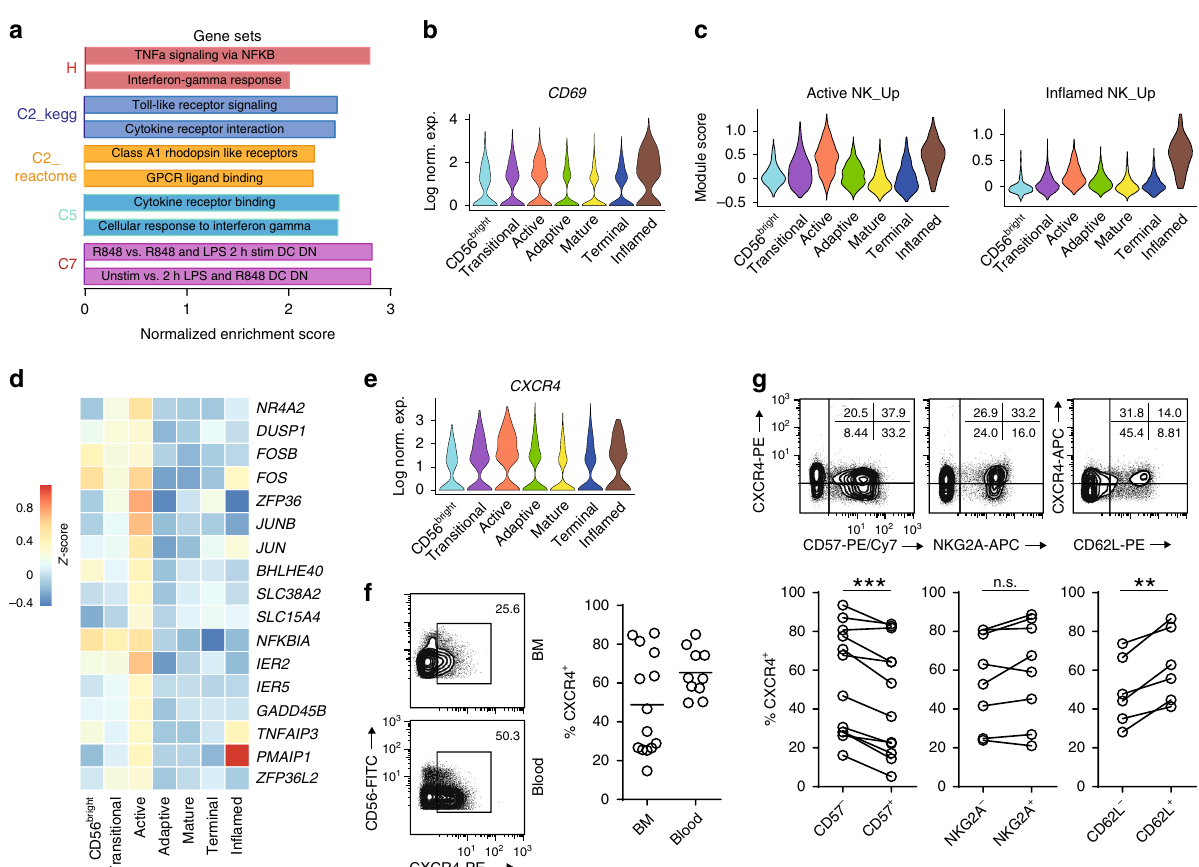
Fig. 4 Active NK cells with a unique transcriptome pro fi le. a Top two enriched gene sets (ranked by normalized enrichment score) of fi ve different datasets from GSEA of the “ In fl amed NK ” cluster compared to the rest of the cells were plotted. b The expression of CD69 in the BM sample was shown as a violin plot. The y -axis represents log-normalized expression value. c Module score was calculated using up-regulated DEGs of “ Active NK ” (left) or “ In fl amed NK ” (right) cluster from BM sample and plotted via violin plots. d Up-regulated IEGs from “ Active NK ” cluster were plotted using heatmap of the BM sample. e The expression of CXCR4 in the BM sample was shown as a violin plot. The y -axis represents log-normalized expression value. f Percentage of CXCR4 + NK cells (gated on Lin − CD56 + cells) was evaluated via fl ow cytometry. g The expression of CXCR4 in CD57 + / − , CD62L + / − , or NKG2A + / − CD56 dim NK populations from BM was assessed via fl ow cytometry (top). Percentage of CXCR4 + cells within each population were quanti fi ed (bottom). n ≥ 6 from two to fi ve independent experiments. Paired Student ’ s t test was used for the statistical analysis. * P < 0.05; ** p < 0.01; *** p < 0.001; n.s. stands for “ not signi fi cant. ” Source data for f and g are provided as a Source Data fi le. See also Supplementary Fig.